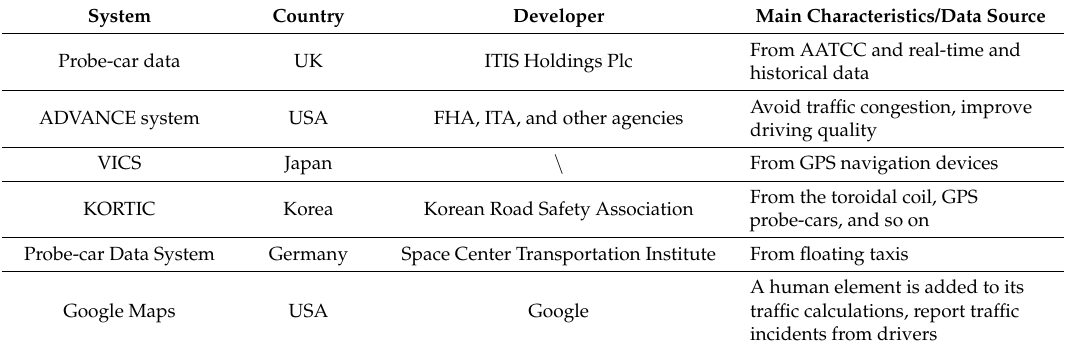
Table 1. Research and applications of intelligent transport systems. AATCC, Automobile Association Traffic Control Centre; FHA, Federal Highway Administration; ITA, Illinois Transportation Authority; GPS, Global Positioning System; VICS, Vehicle Information and Communication